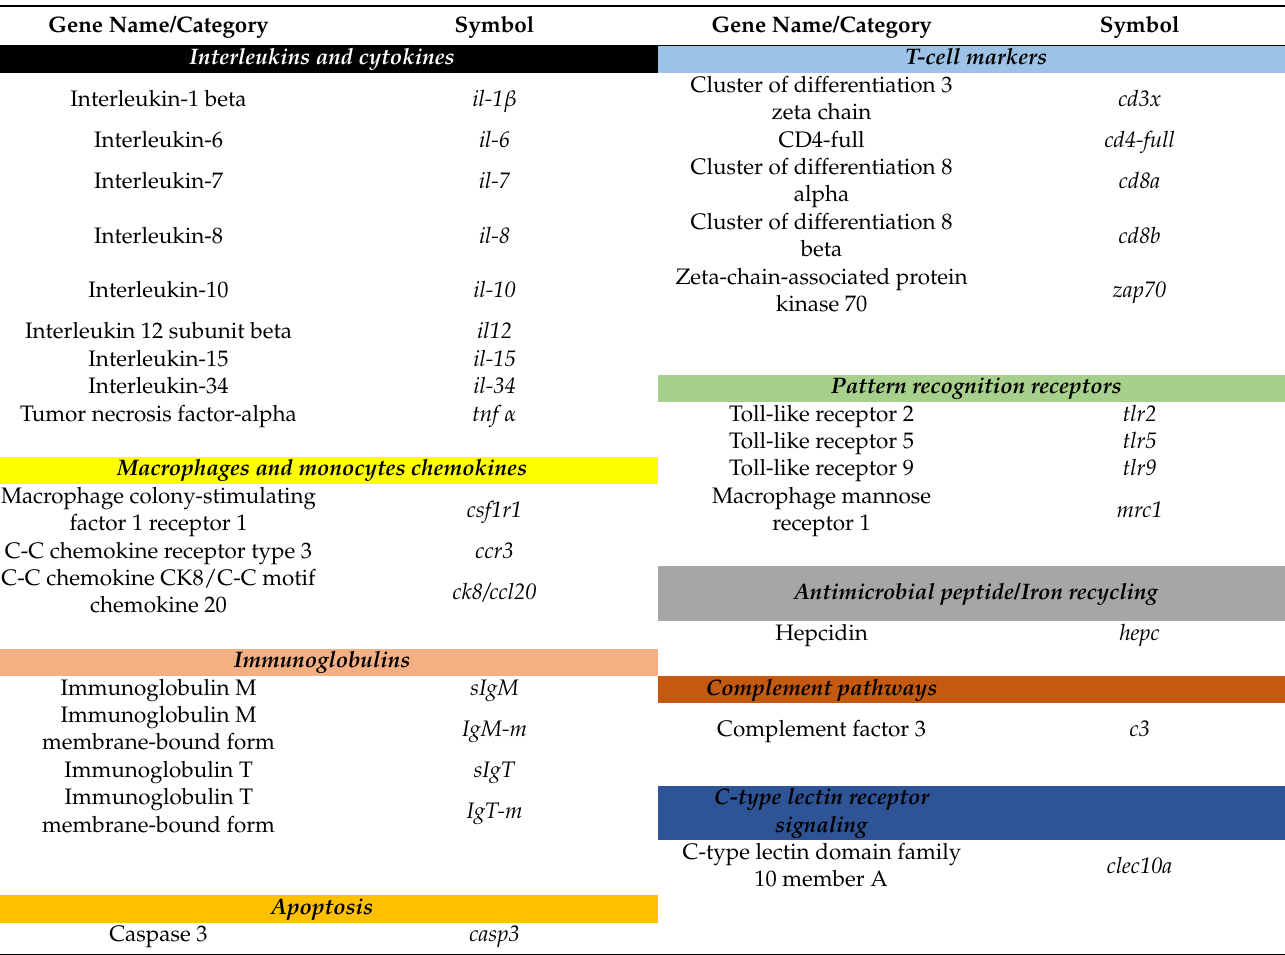
Table 3. Genes included in head kidney pathway-focused PCR